Question: Write the caption for this figure.
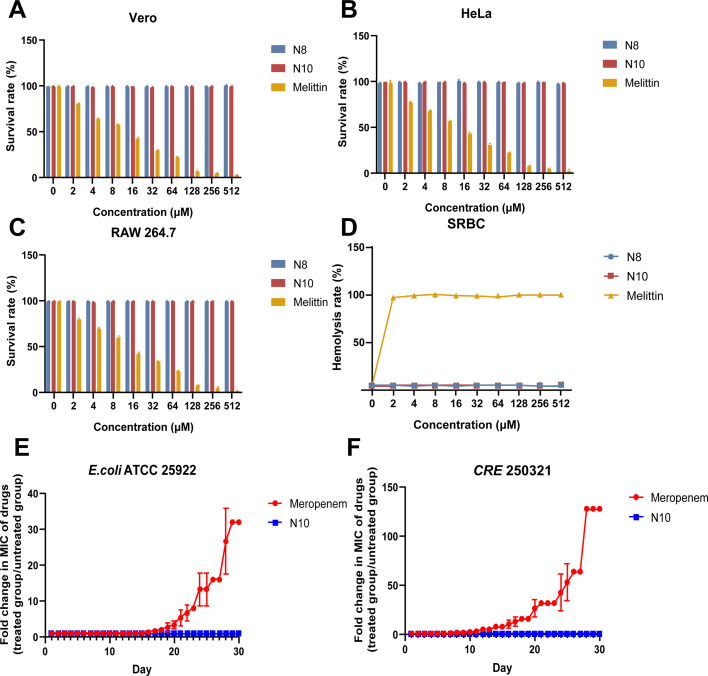
Answer: N10 neither has cytotoxicity nor the ability to induce drug-resistant mutations. ( A–C ) Cytotoxicity to Vero, HeLa, and RAW264.7 cells after treatment with 0, 2, 4, 8, 16, 32, 64, 128, 256, and 512 μg/mL of the peptides N8 and N10 and the control drug melittin. ( D ) Hemolytic activities of the peptides N8 and N10. Fresh sheep erythrocytes were mixed with 0, 2, 4, 8, 16, 32, 64, 128, 256, or 512 μg/mL N8 or N10 peptide at 37°C. The same concentrations of melittin were used as positive controls. ( E ) Drug resistance testing of meropenem and N10 in E. coli ATCC 25922 . ( F ) Drug resistance testing of meropenem and N10 in CREC 250321 .